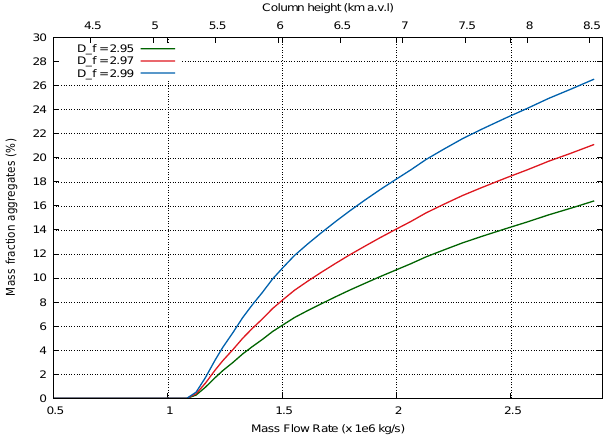
Figure 10. FPLUME aggregation model results for Eyjafjallajökull 6 May phase. Total mass fraction of aggregates (in %) versus mass flow rate (in kgs − 1 ) and column height (in km a.v.l.) for different values of the fractal exponent D fo (in these simulations we used c H = 1 . 1 and the presence of meteoritic water in the plume was not considered). The model predicts a 10% in mass of wet aggregates for column heights between 6.0 and 7.0km (a.v.l.). Input parameters were fixed as in Table 5 varying mass flow rate (column height).